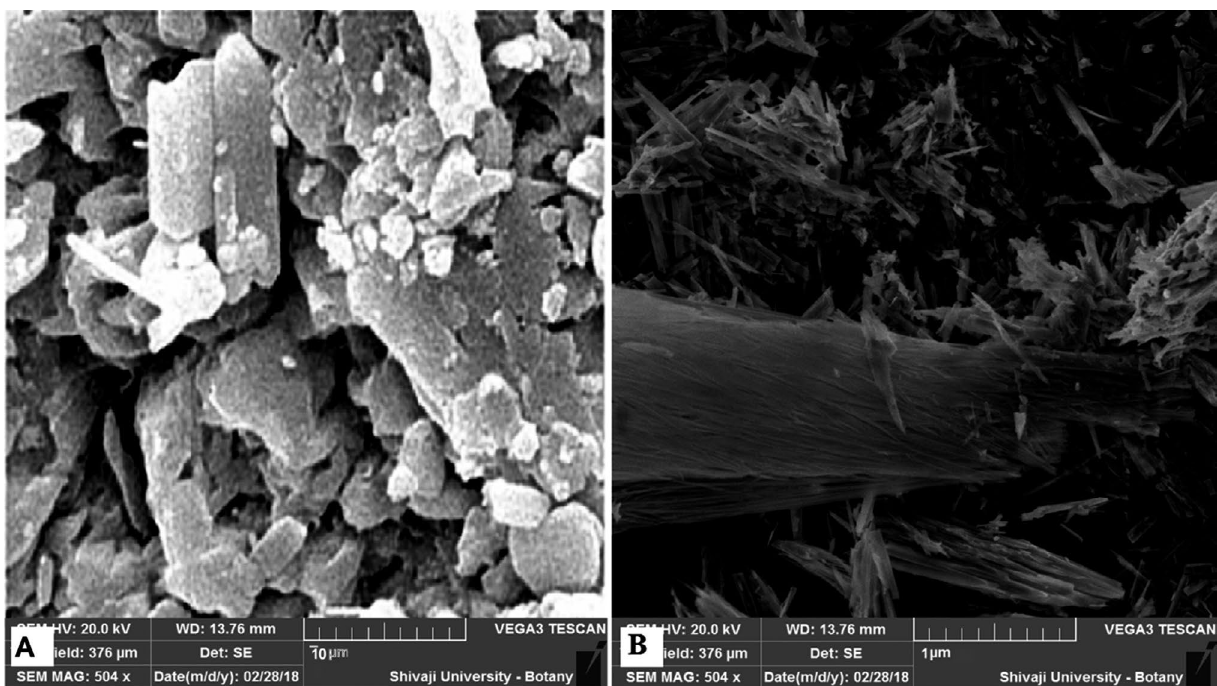
Figure 8. a) SEM images of pure ethinyl estradiol, (b) optimized nanosuspension